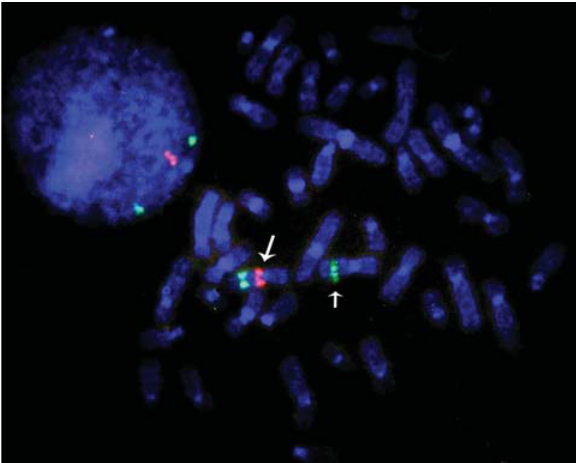
Figure 2 - Metaphase after fluorescent in situ hybridization (FISH)with VYSIS ® Williams Syndrome Region. The normal chromosome (long ar- row) shows a pink signal at 7q11.23, and a green signal at the control seg- ment. On the abnormal chromosome 7 (small arrow), only the control green signal is observed, indicating a deletion at